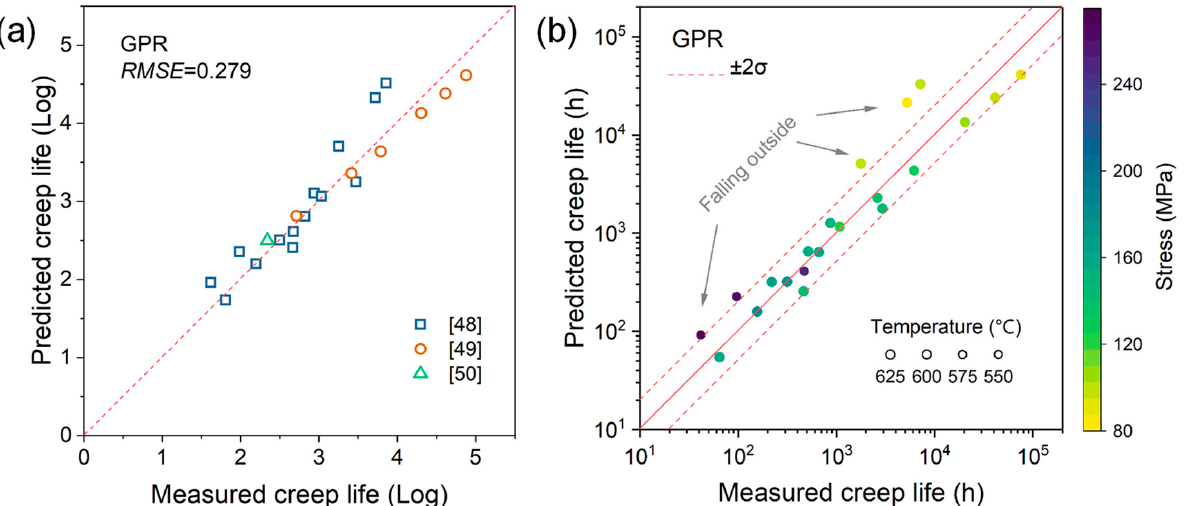
Figure 9. Prediction results of creep rupture life by GPR model with the validation dataset: ( a ) Pre- diction results of creep life from various literature in log scale; ( b ) Predicted creep life vs. measured creep life.